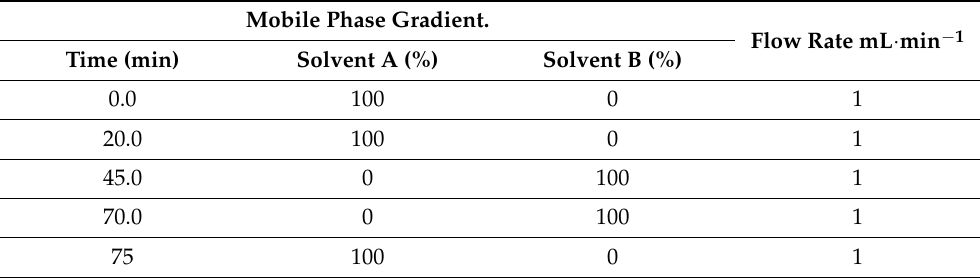
Table 1. Phase gradient used in the HPLC measurements. Mobile Phase Gradient.